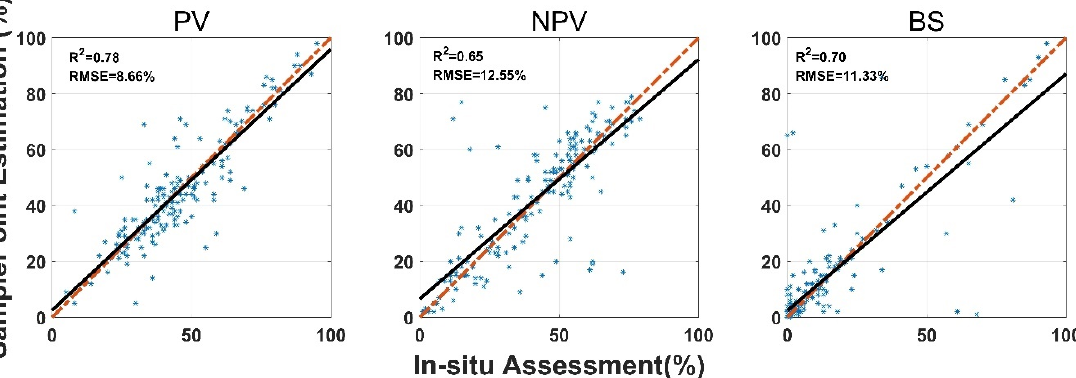
Figure 4. Comparison of in situ assessment and SamplePoint estimation for PV, NPV, and BS fraction cover (red dashed line is the 1:1 relationship; dark solid line is the linear regression). The regression significance level ( p -value) is 0.01.